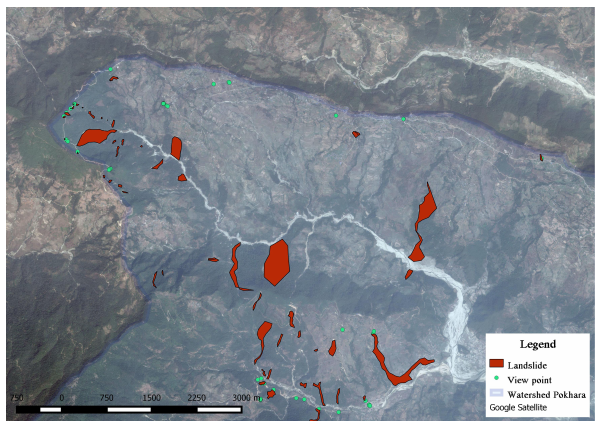
Figure 13. Distribution of landslides in Phewa Lake watershed based on the 2-day data collection.